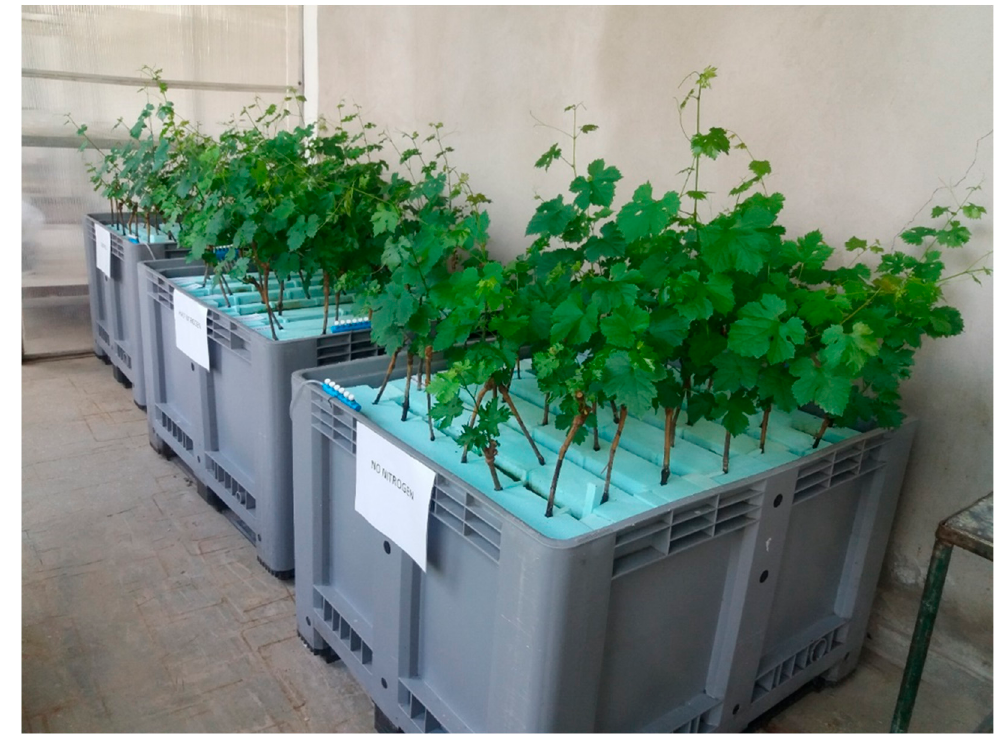
Figure 1. Photo of the experimental plants.